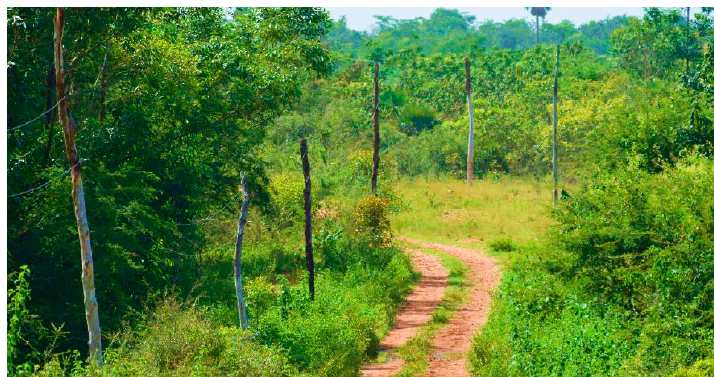
Figure 4. Electricity low-voltage distribution network in Yaguá. Table 1. Households’ relative location and voltage drop. Distance from Households